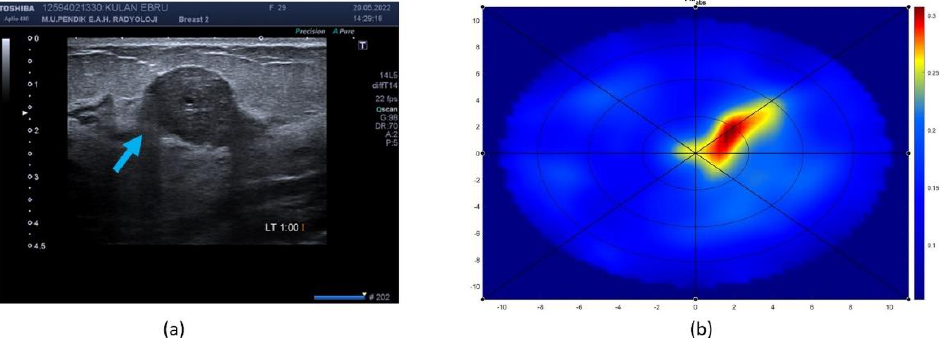
location as reported by MRI.